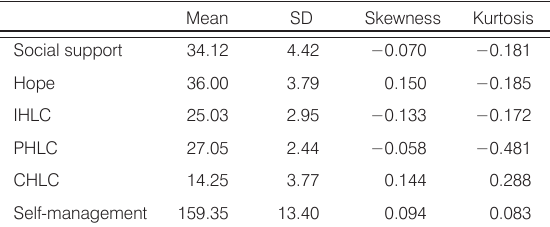
Table 2. Descriptive statistics among study variables ( N =